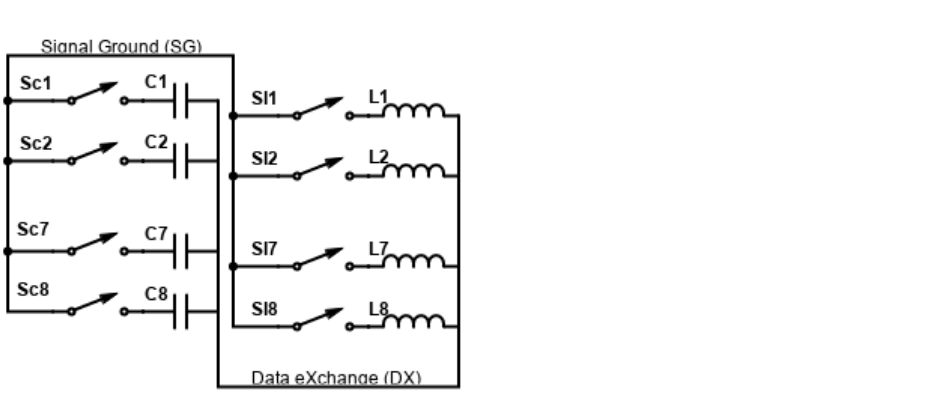
Coil selection to pulse generator—Master only—Figure 4